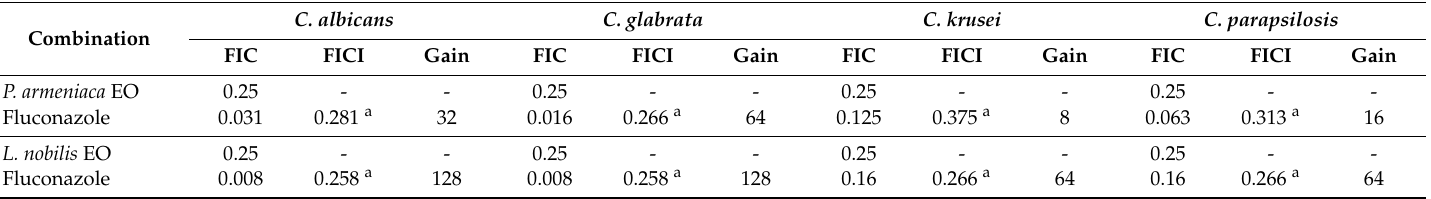
Table 5. Synergistic interaction between laurel ( L. nobilis ) and apricot ( P. armeniaca ) essential oils and fluconazol against clinical pathogenic